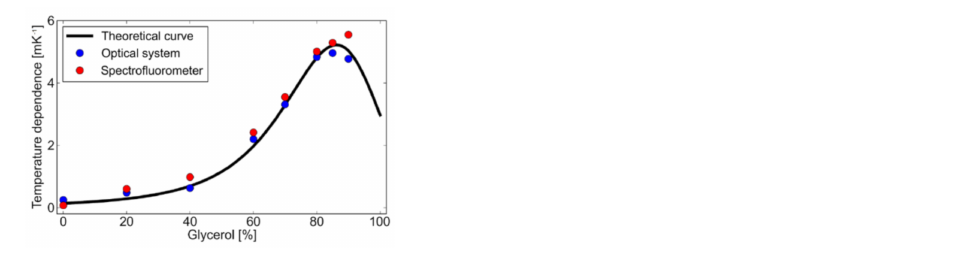
Figure 8. Temperature dependence of theoretical and measurement anisotropies (absolute values).